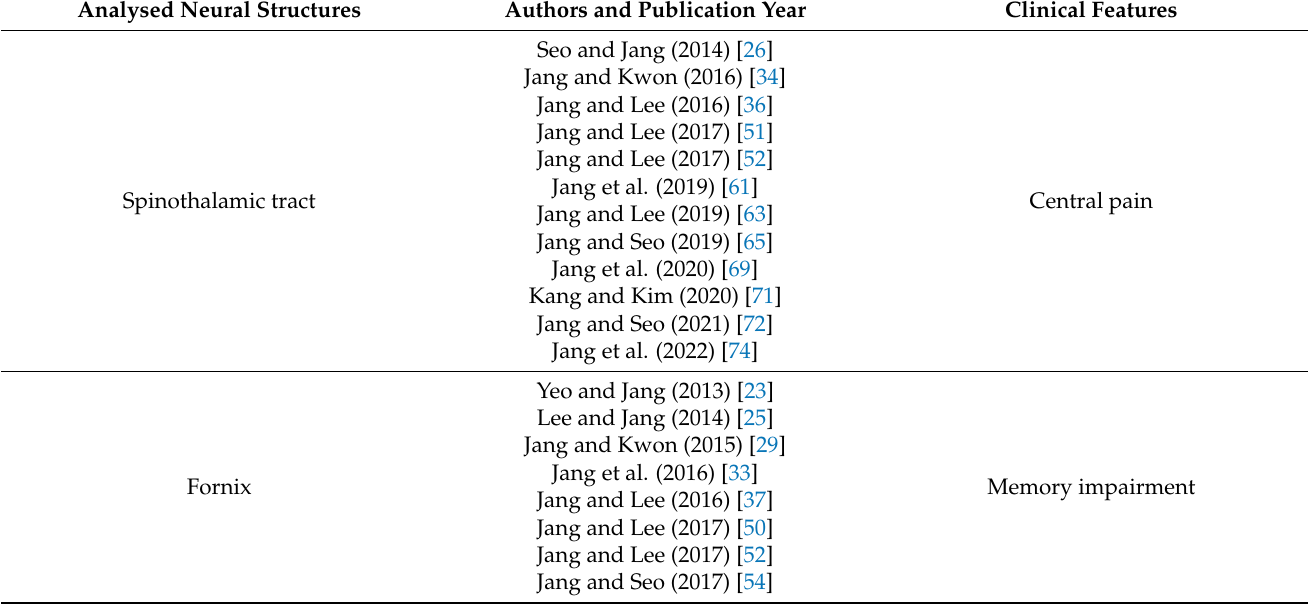
Table 1. Diffusion tensor imaging studies reporting a traumatic axonal injury in patients with a concussion or mild traumatic brain